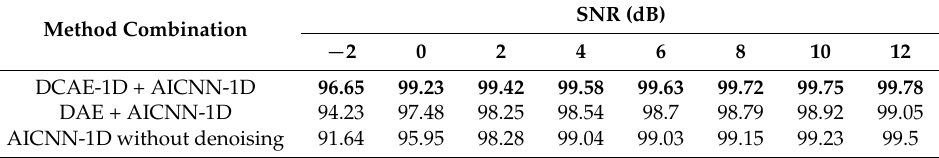
Figure 9. Diagnosis accuracy of AICNN-1D with different denoising processes. Table 6. Diagnosis accuracy of AICNN-1D with different denoising processes.